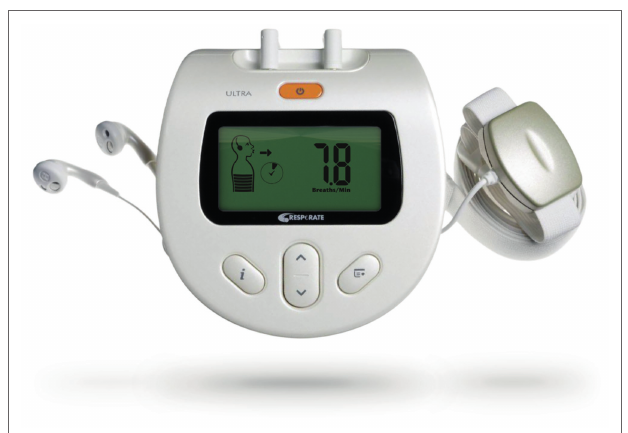
FIGURE 1 | The RESPeRATE device used for device-guided breathing intervention (with the permission of the manufacturer).